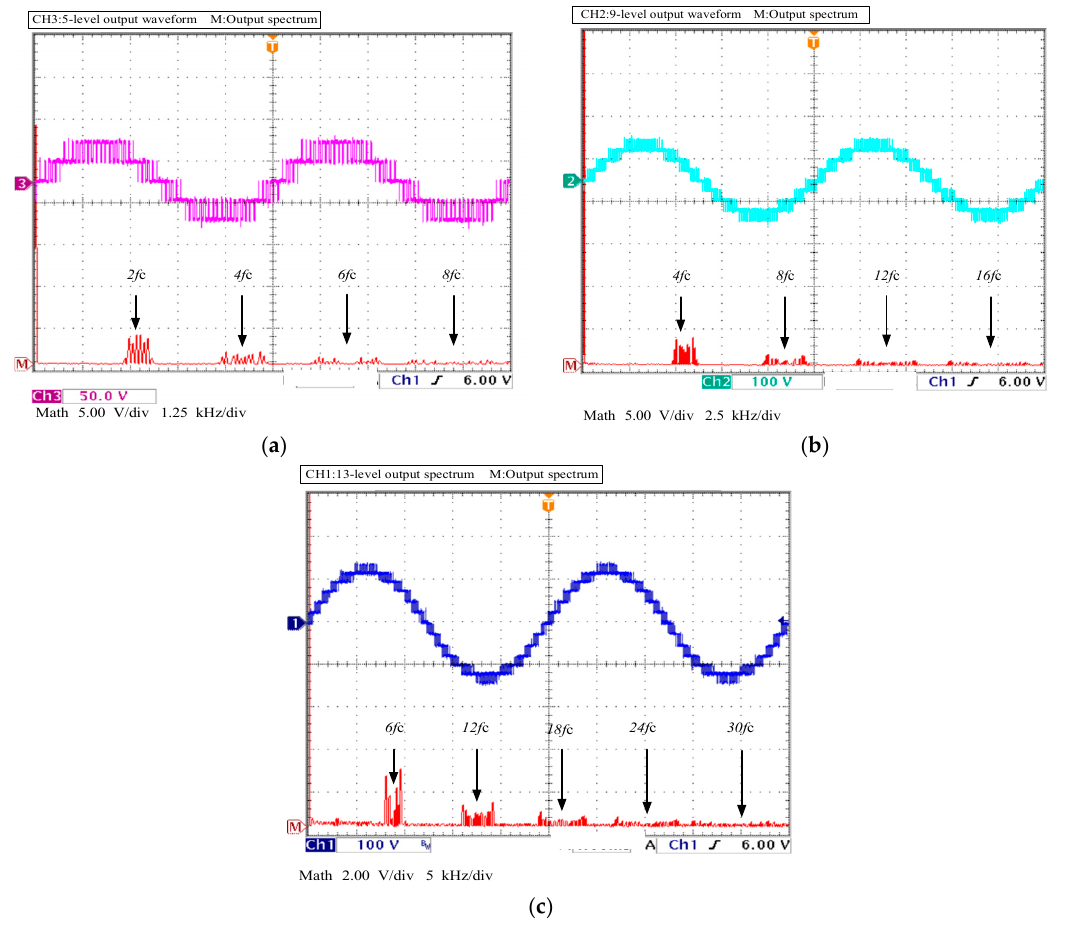
Figure 10. Experimental results. ( a ) Voltage and spectrum of a one modules inverte. ( b ) Voltage and spectrum of a two modules cascaded inverter. ( c ) Voltage and spectrum of a three modules cascaded inverter.